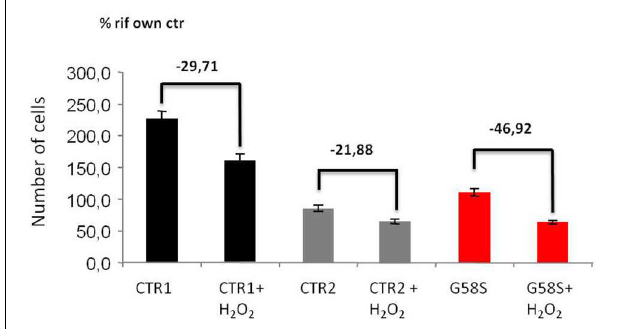
FIGURE 6 | Fibroblasts with C19orf12 mutation are more sensitive to cell death. Human fibroblasts were treated with Hydrogen Peroxide (2mM H 2 O 2 for 5 h). Apoptosis was evaluated using an automated nuclei count analysis. Numbers above bars indicate the percentage of cell death in the presence of H 2 O 2 as compared to the corresponding untreated sample.